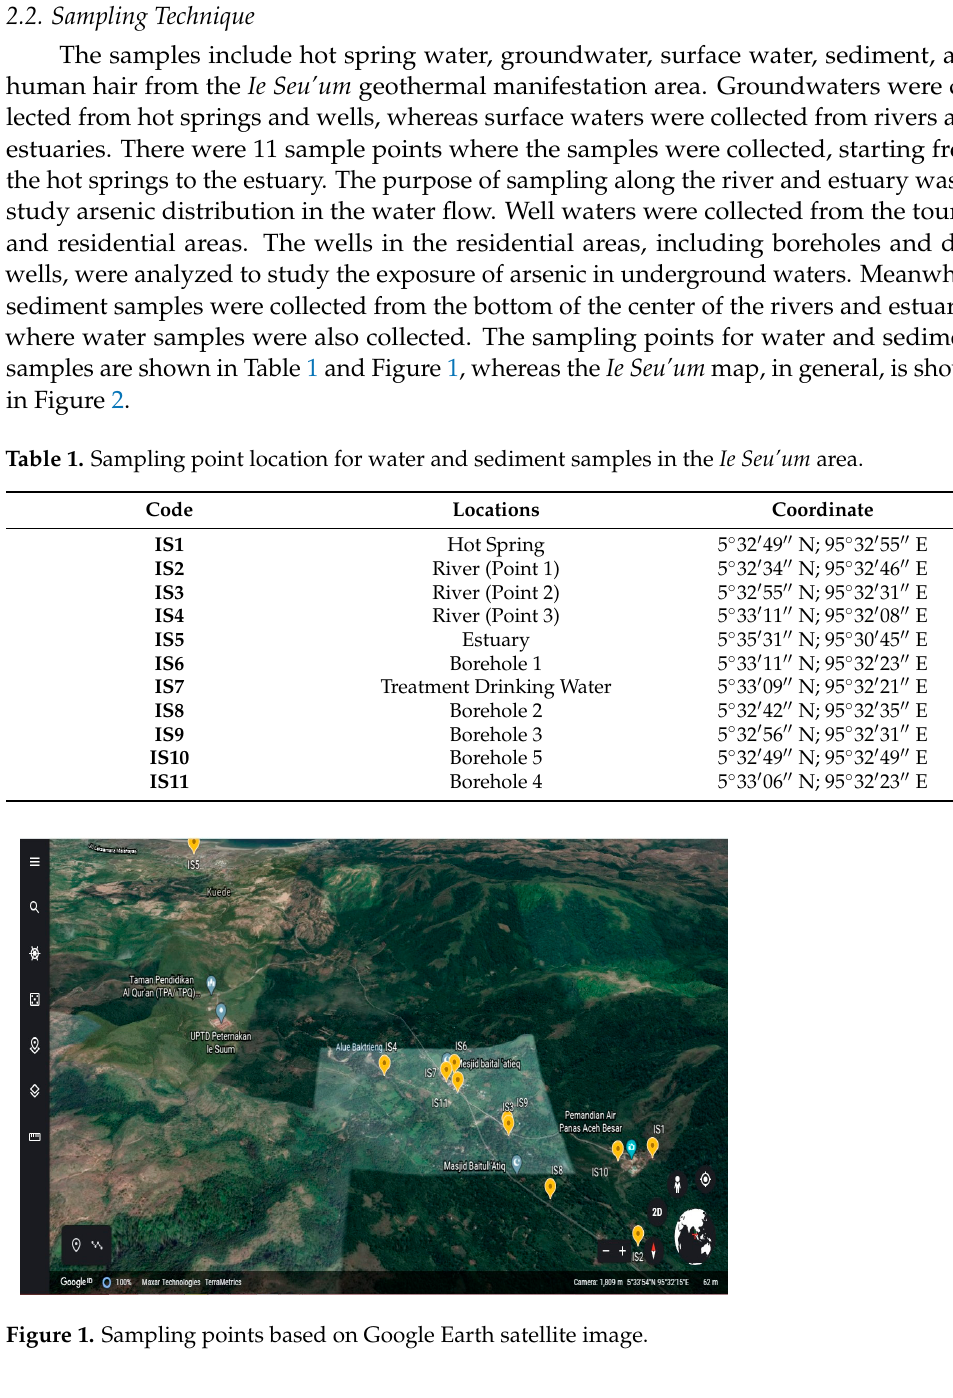
Figure 2. Map of the geothermal area of Ie Seu’um and its condition with Mt. Seulawah. 2.2.1. Water Sampling Water samples were collected using a plastic scoop and stored in a PE bottle that had been rinsed once with nitric acid and three times with sample water. The samples were preserved with the addition of nitric acid until pH < 2 and cooled at 4 ± 2 °C [16]. The